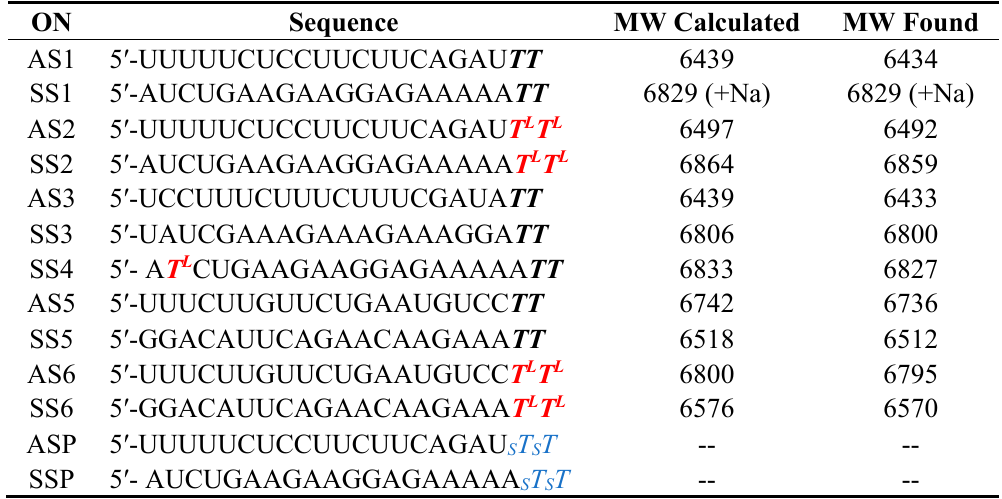
Table 1. Sequences and mass spectrometry analyses of oligonucleotides. T L : L -threoninol- thymine monomer, T S : thymidine monomer with phosphorothioate linkage, T : thymidine.